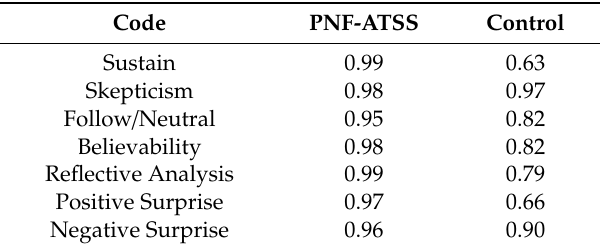
Table 3. Interrater reliability (ICCs) based on consistency agreement